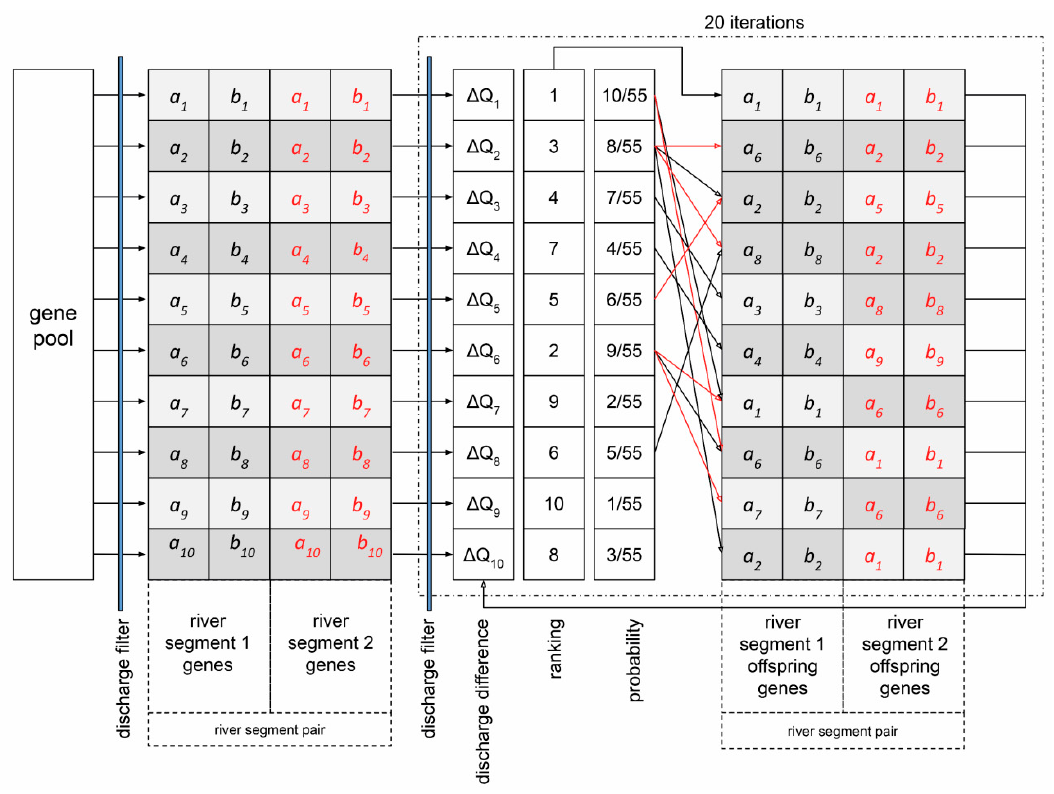
Figure 12. Schematic overview of the genetic algorithm. For a river segment pair, 10 AHG parameter pairs (genes) are randomly drawn from the gene pool. For each gene pair, the corresponding discharge time series are calculated and tested on their maximum and minimum value. If the maximum or minimum discharge criteria are not met, a new gene is drawn from the gene pool and tested. When all genes meet the criteria, the di ff erence in discharge is calculated and ranked. The genes with the smallest di ff erence are then assigned to the highest probability (10 / 55) to get drawn for the next generation of gene pairs, the ones with the greatest di ff erence to the lowest probability (1 / 55). Furthermore, the best gene pair is automatically passed to the next generation. In addition, with a probability of 1%, a gene is randomly selected and “mutated” by applying a random factor. This process is repeated 20 times for every possible pair of river segments.